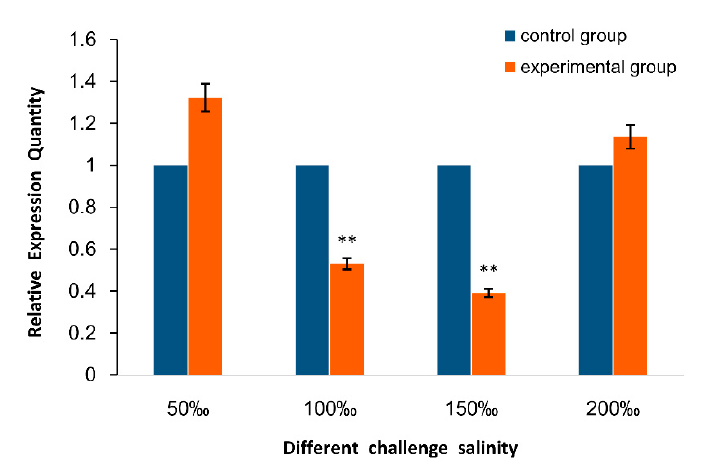
Figure 3. Quantitative real-time qPCR analysis of the expression levels of As – RAD9 in different salinity challenge. The expression level of As – RAD9 mRNA was adjusted to the control group at 28 ‰ salinity, and the expression level of As – RAD9 mRNA was measured at four different salt concentrations. Data are mean ± SD of three replicate experiments, ** indicates a very significant difference compared to the control ( P < 0.01).